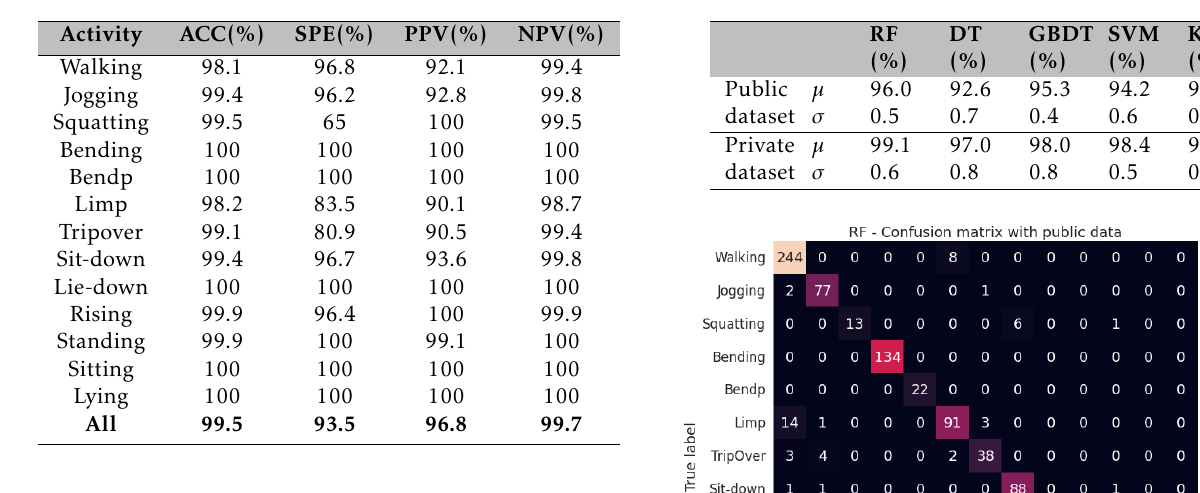
Tab 4. Evaluation of applying the RF algorithm on the public dataset.